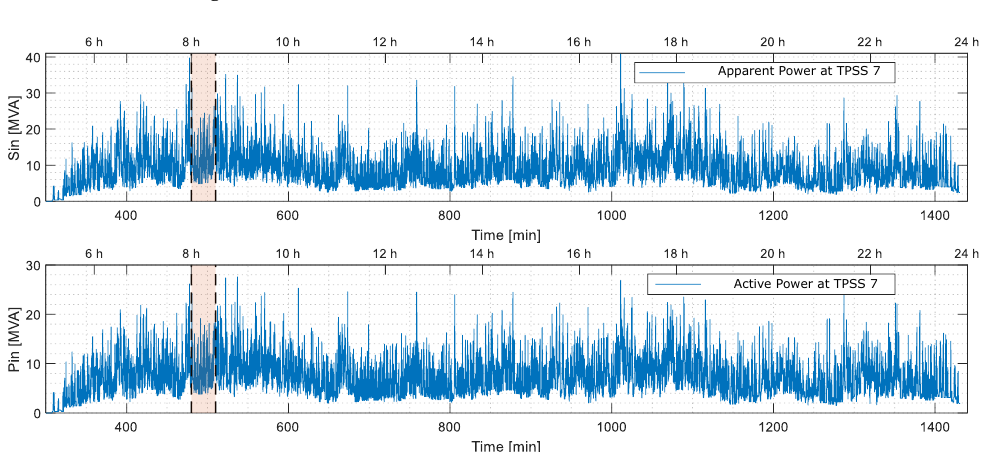
Figure 6. Apparent and active power consumed at substation #7.